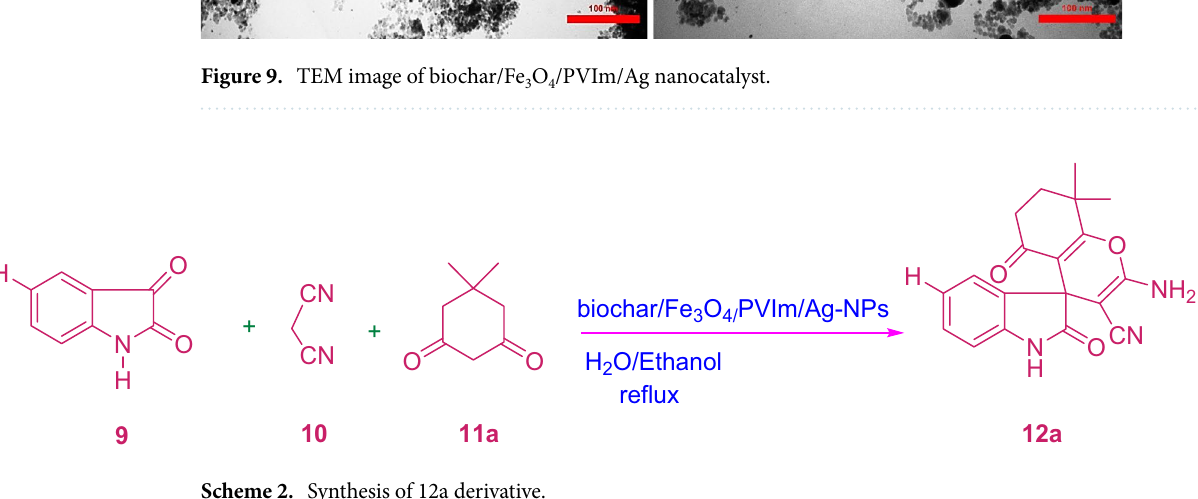
Scheme 2. Synthesis of 12a